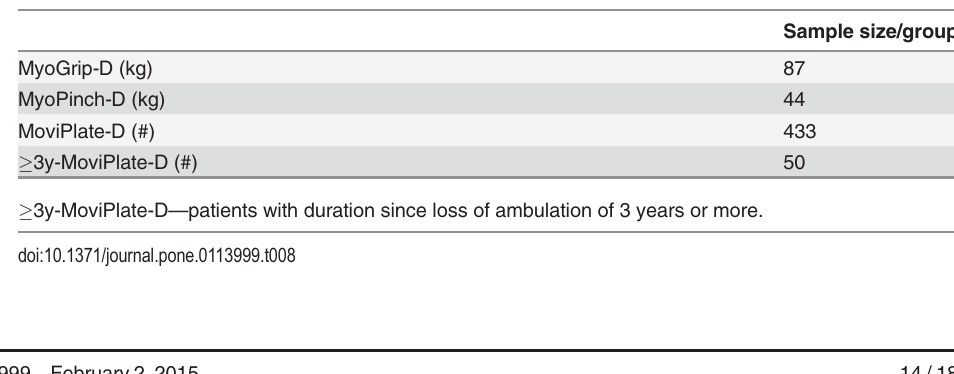
Table 8. Sample size estimation per group in a clinical trial to detect an improvement stabilization of strength or MoviPlate score on the dominant (D)